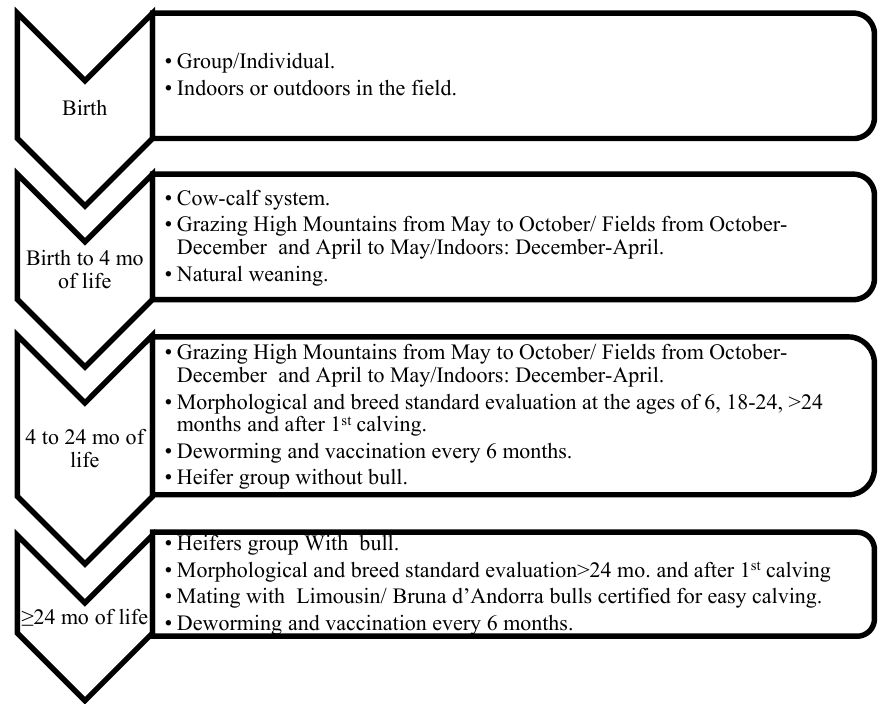
Figure 4. Management, nutritional, and husbandry protocols used during the calf and heifer rearing process of BA females destined for cow replacement.